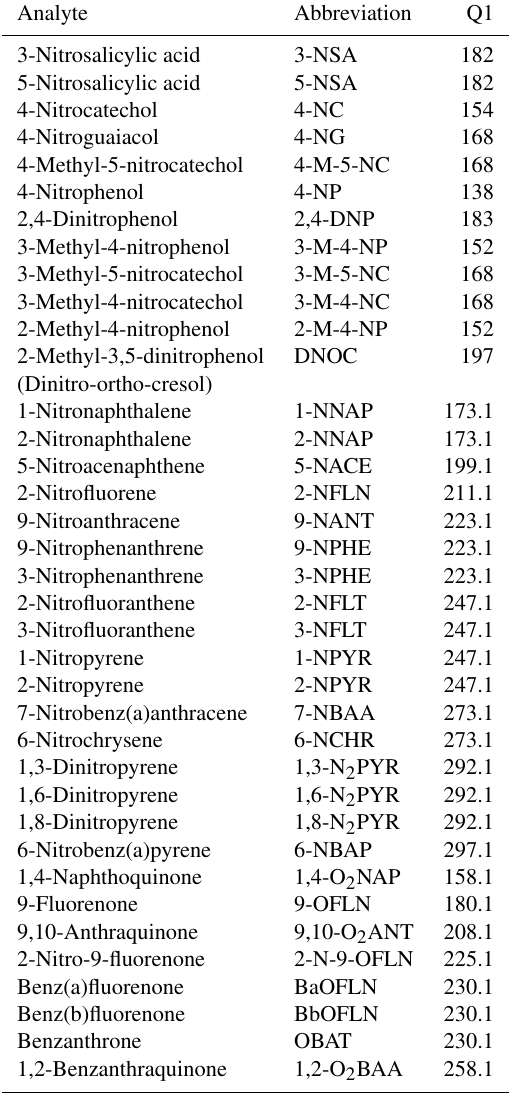
Table 2. Analytes targeted in this study. Analyte